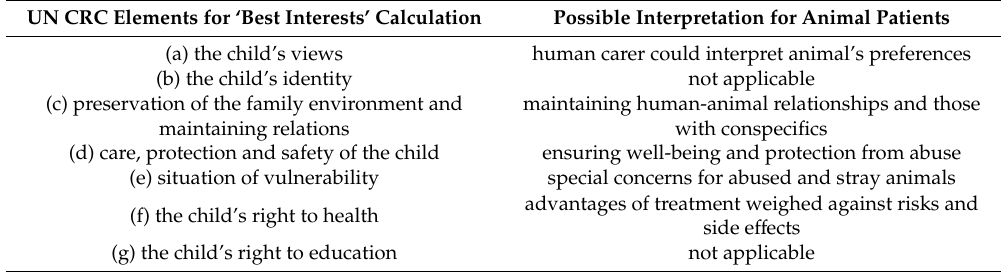
Table 1. The components suggested for a “best interests’ calculation for children with interpretation for companion animal